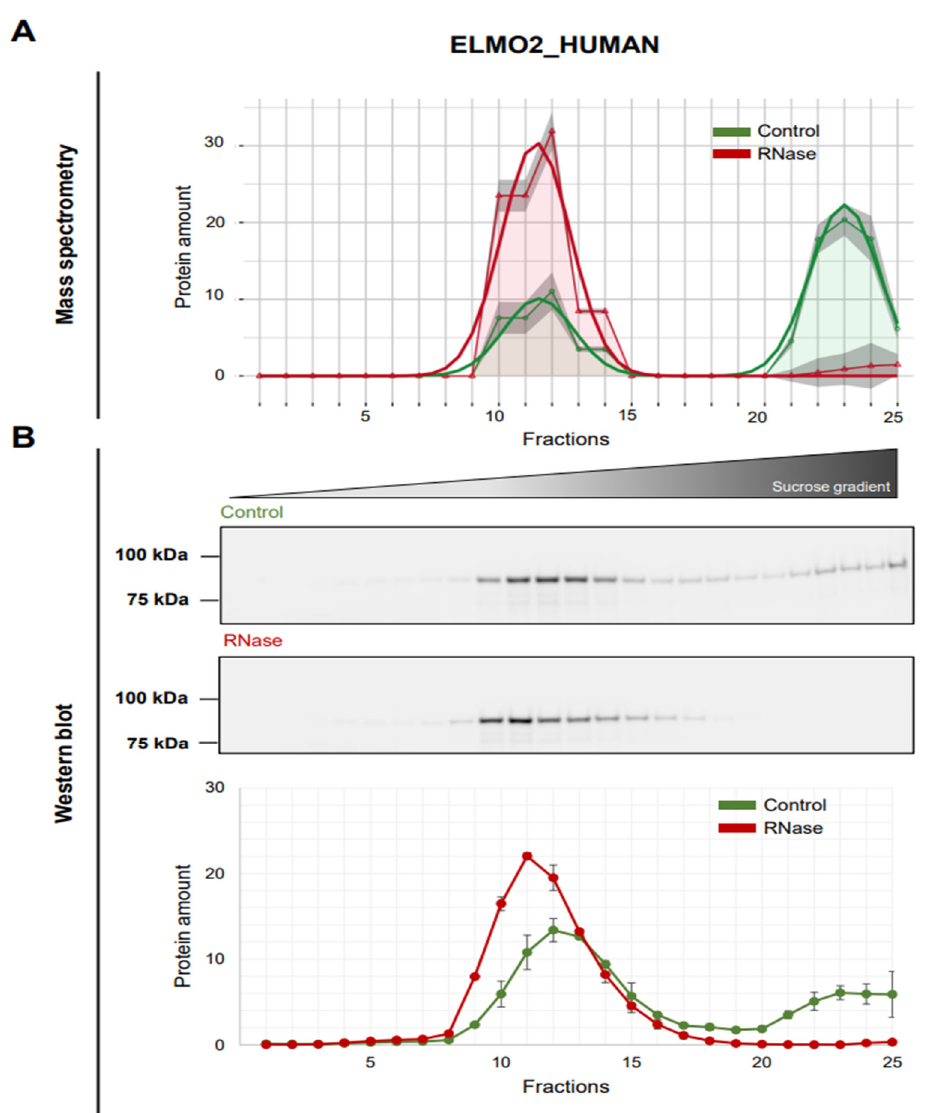
Figure 5. RNA dependence of ELMO2. ( A ) Mass spectrometry analysis of the ELMO2 protein in all 25 fractions as in Figure 4A. ( B ) Top panel: Western blot showing the protein amount of ELMO2 (83 kDa) distributed across the 25 fractions in control and RNase-treated samples. Bottom panel: Graph showing the quantitative analysis of the Western blots of all three replicates ( n = 3) represented by mean and SEM. The protein amount was normalized to 100. Original blots: see File